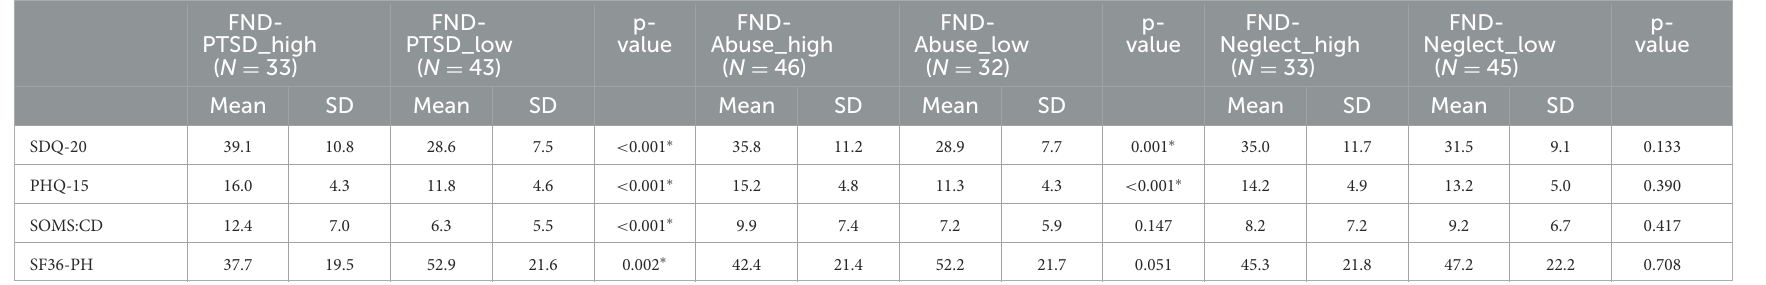
TABLE 2 Symptom severity and physical health scores in functional neurological disorder stratified by trauma